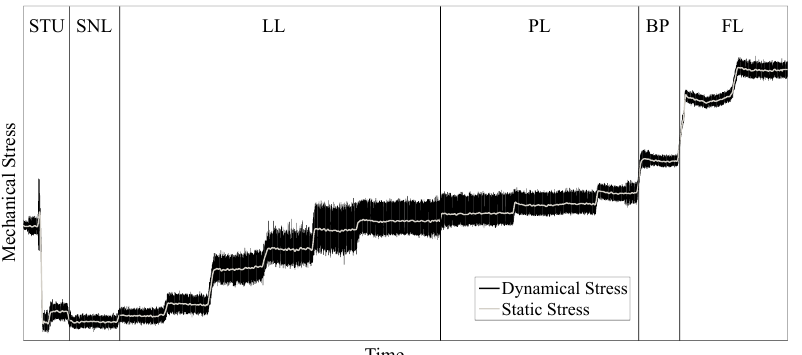
Figure 6. Stress-time correlation at the DMS position of a middle-head Francis runner (STU = Start-Up, SNL = Speed-No-Load, LL = Low-Load, PL = Part-Load, BP = Best-Point, FL =